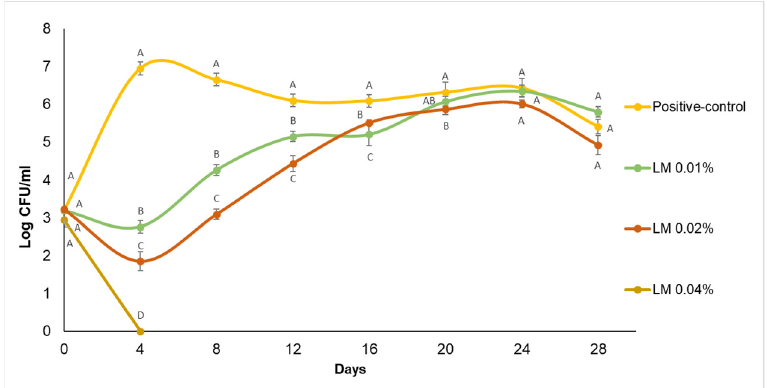
Figure 3. Effect of lemon myrtle (LM) nanoemulsion essential oil on the growth rate of Zygosaccha- romyces bailii in clear apple juice during 28 days of storage at 25 °C. Means with different letters on the same day are significantly different at p < 0.05.